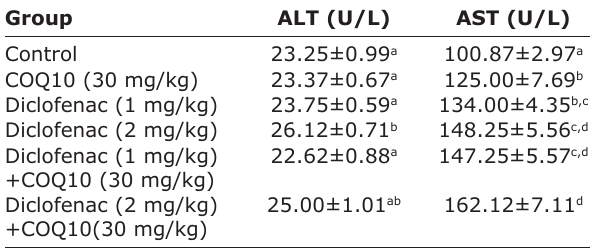
Values in each column followed by different superscript letters are significantly different at 5% level of significance. ALT=Alanine aminotransferase, AST=Aspartate